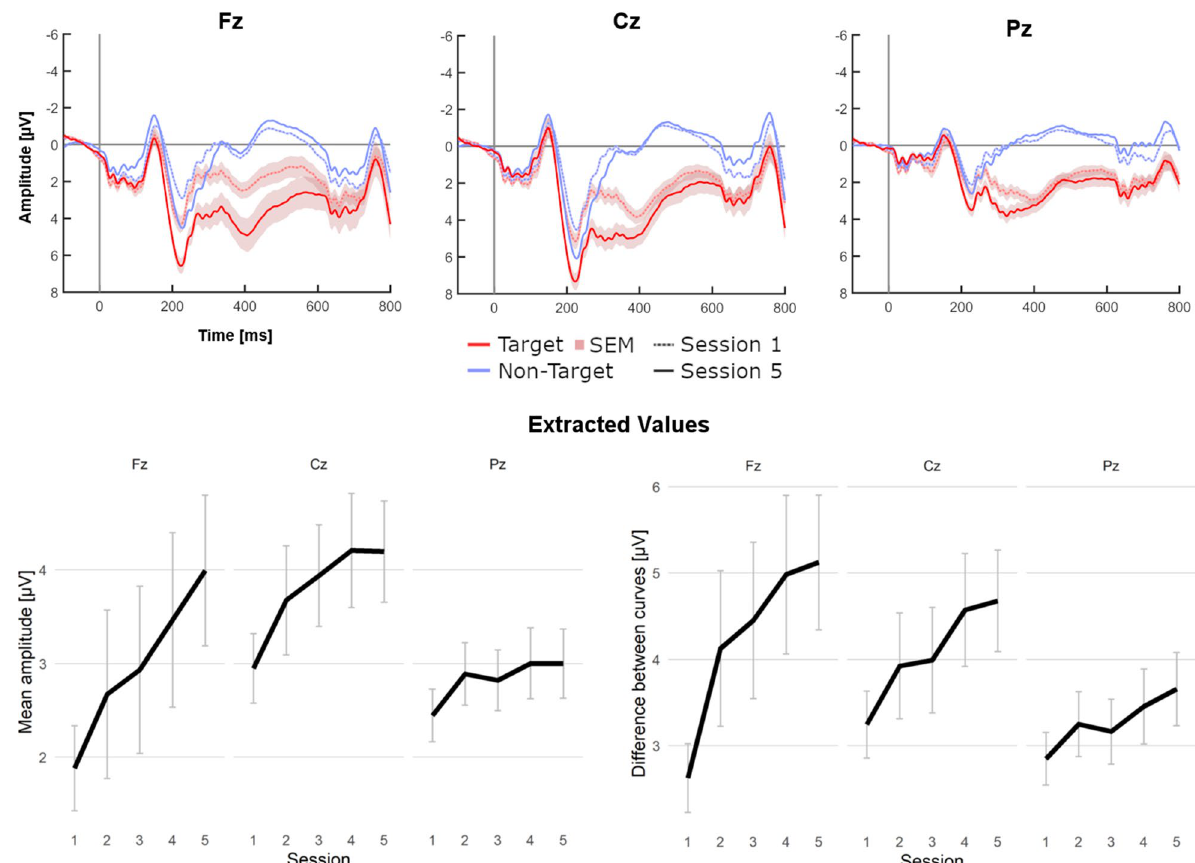
Figure 3. Grand average ERP data. Top: ERP shape comparison between first and last session at Fz, Cz and Pz (calibration and copy task). Bottom: Extracted mean values (amplitude & curve difference) across all sessions. Shaded areas and error bars indicate standard error of the mean (SEM).